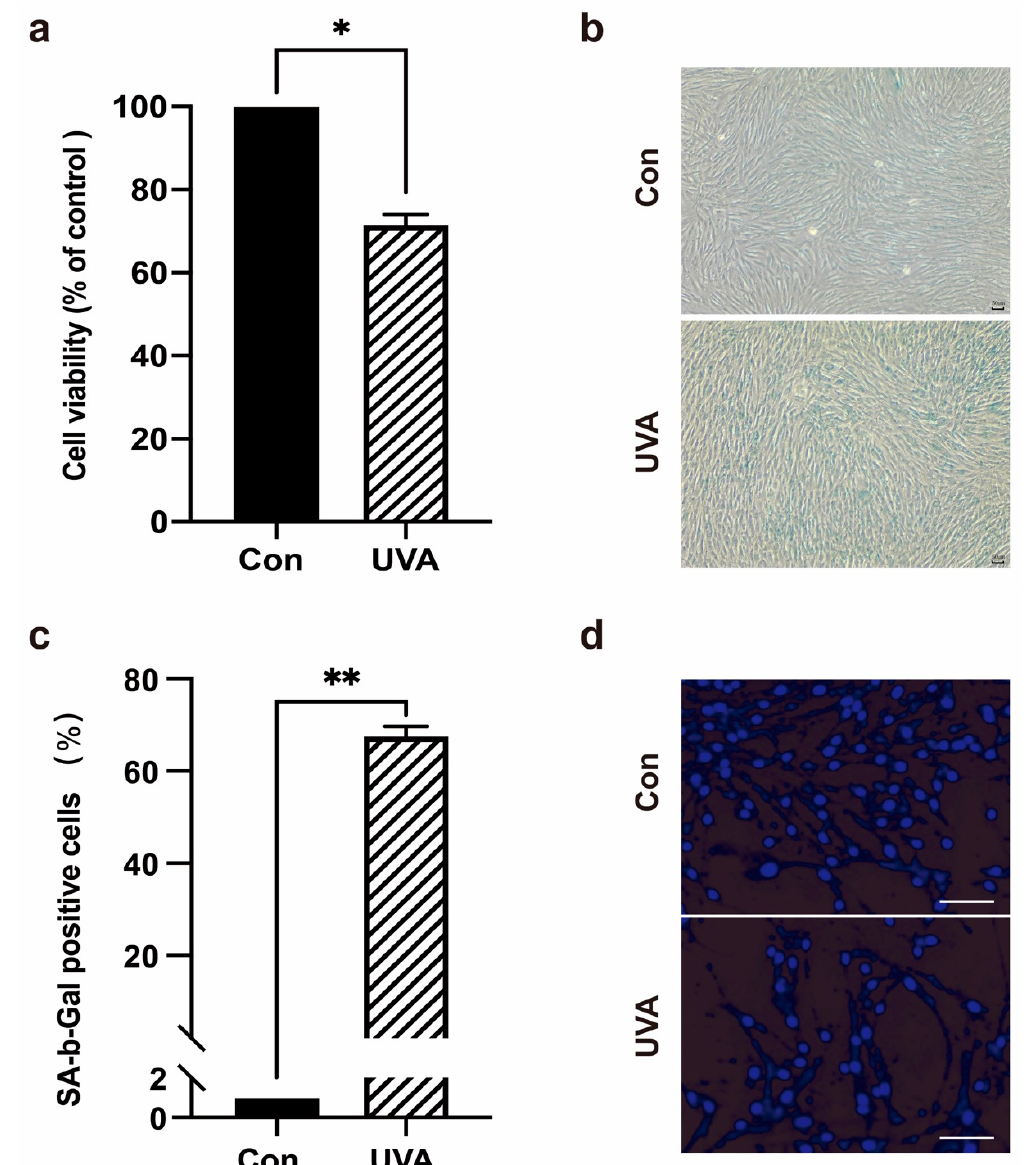
Figure 1. UVA can induce photoaging in foreskin dermal fibroblasts. ( a ) Cells were treated with UVA. The cell viability of HFFs were detected by MTT assay. ( b , c ) Cells were treated with UVA, the activity of senescence ‐ associated β‐ galactosidase and the percentage of cells positive for SA ‐β‐ galactosidase staining (40×) were measured. ( d ) HFFs were treated with UVA, stained with Hoechst 33258. Cell morphology was observed by fluorescence microscopy (200×). Data are presented as mean ± SD, n = 3. * p < 0.05, ** p < 0.01.